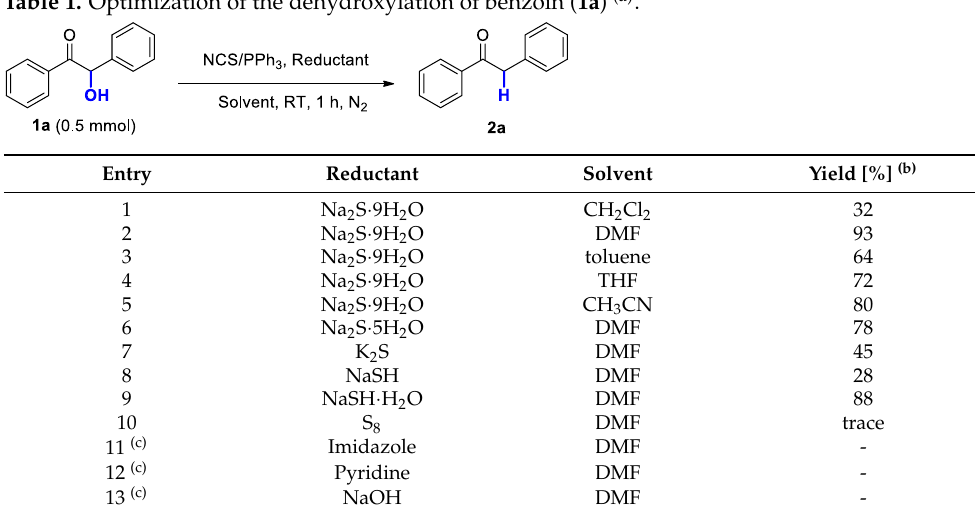
Table 1. Optimization of the dehydroxylation of benzoin ( 1a ) (a) .